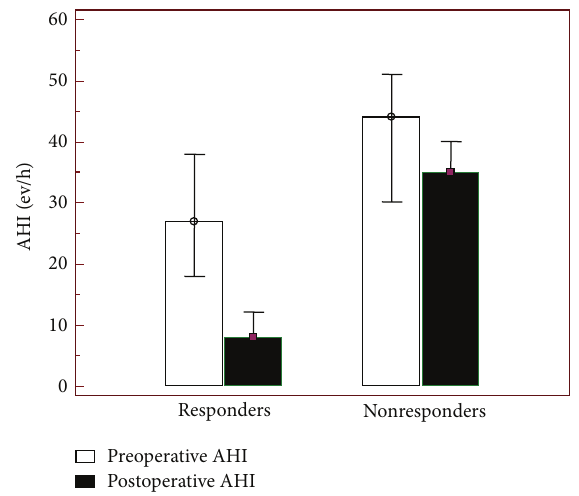
Figure 1: Comparison of pre-/postoperative AHI reduction between responder and nonresponder groups.